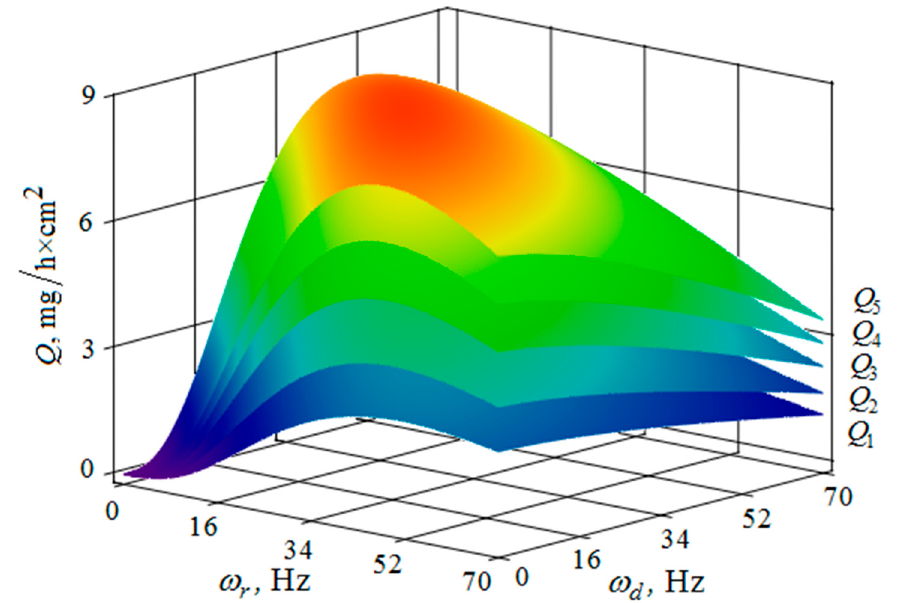
Figure 21. Dependence of the metal removal Q , mg/h·cm 2 on the frequencies of oscillations ω r , Hz and ω d , Hz of the reservoir working surfaces and the processed part surface for di ff erent values of the diameters of the abrasive granules: ( Q 1 , Q 2 , Q 3 , Q 4 , Q 5 —metal removal at d = 10; 15; 20; 25; 30 mm); amplitudes of oscillations of the reservoir A r working surfaces and the part A d 1 mm.